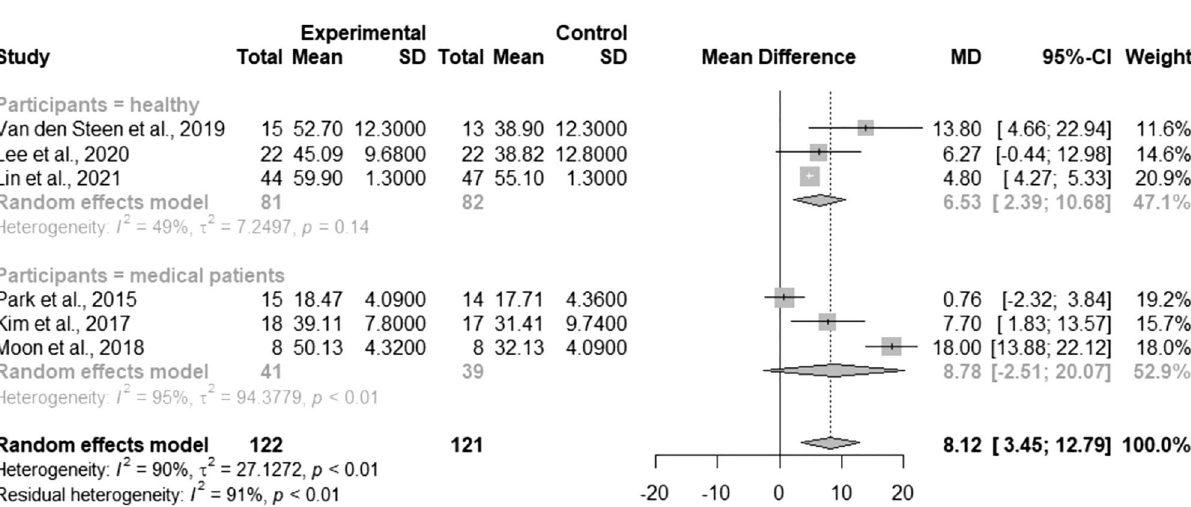
Figure 5. Forest plot of pooled posterior tongue strength after the intervention, comparing the tongue strengthening exercise group and the control group. MD mean difference, CI confidence interval.